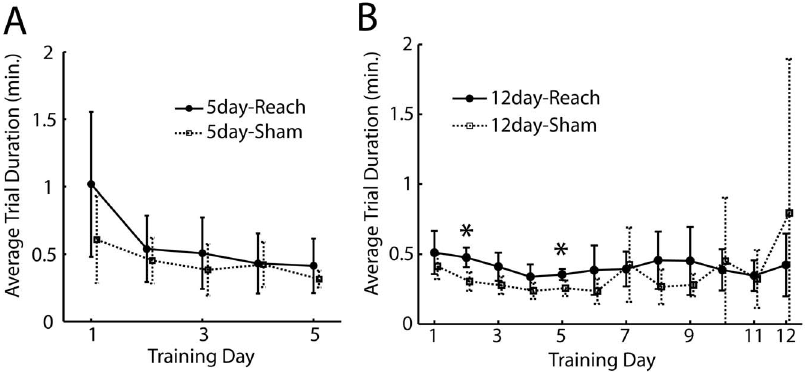
Figure 11. The Sham animals might be more motivated to perform the pellet retrieval task then the Reach animals. We used the average trial duration as an indicator of the animals’ motivation to perform the pellet retrieval task. For both the 5-day groups ( A ) and 12-day groups ( B ), trial durations for the Sham animals (dotted line; mean 6 SD; N=4) tended to be lower than those for the Reach animals (solid line; N=4) even though these differences were not statistically significant for all days except two of the days in the 12-day groups (*, p , 0.05). We speculate that the Sham animals might be more motivated or excited to perform the task than the Reach animals because successful pellet retrieval was almost guaranteed for the Sham groups. This difference in the level of motivation could be an explanation for why we observed many differentially expressed probes specific to the Sham groups.